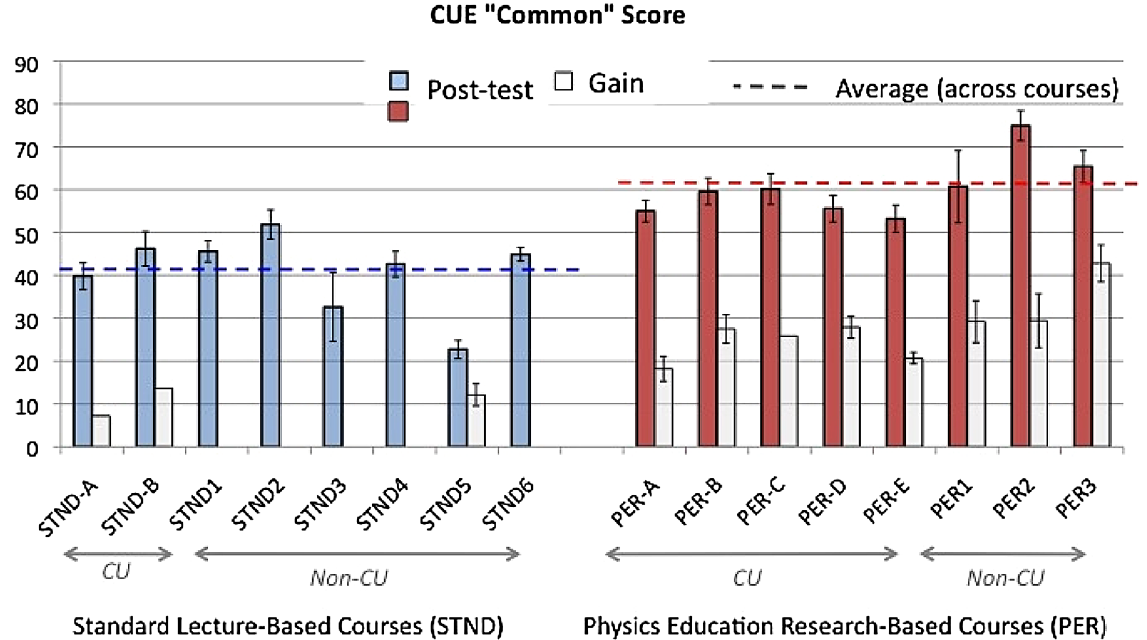
FIG. 7 (color online). ‘‘Common’’ CUE scores across institutions for N ¼ 488 students. ‘‘Post-test’’ represents course average score (% correct) for the subset of CUE questions given in common across all exams (88 out of 118 possible points). ‘‘Gain’’ represents the course average (out of 100%) for the difference between the pretest (60 points) and the matched subset of the post-test (i.e., 60 points). PER courses used the research-based materials developed at CU. STND courses used a standard lecture-based format. Because of the lack of pretests for CU-RES1 and CU STND1 and STND2, pretest scores are estimated (and thus gain scores are effective and lack error bars) based on the stable pretest scores for other semesters. Courses are not listed chronologically. Courses A and B (from final CUE administration) are labeled. Error bars represent 1 standard error of the